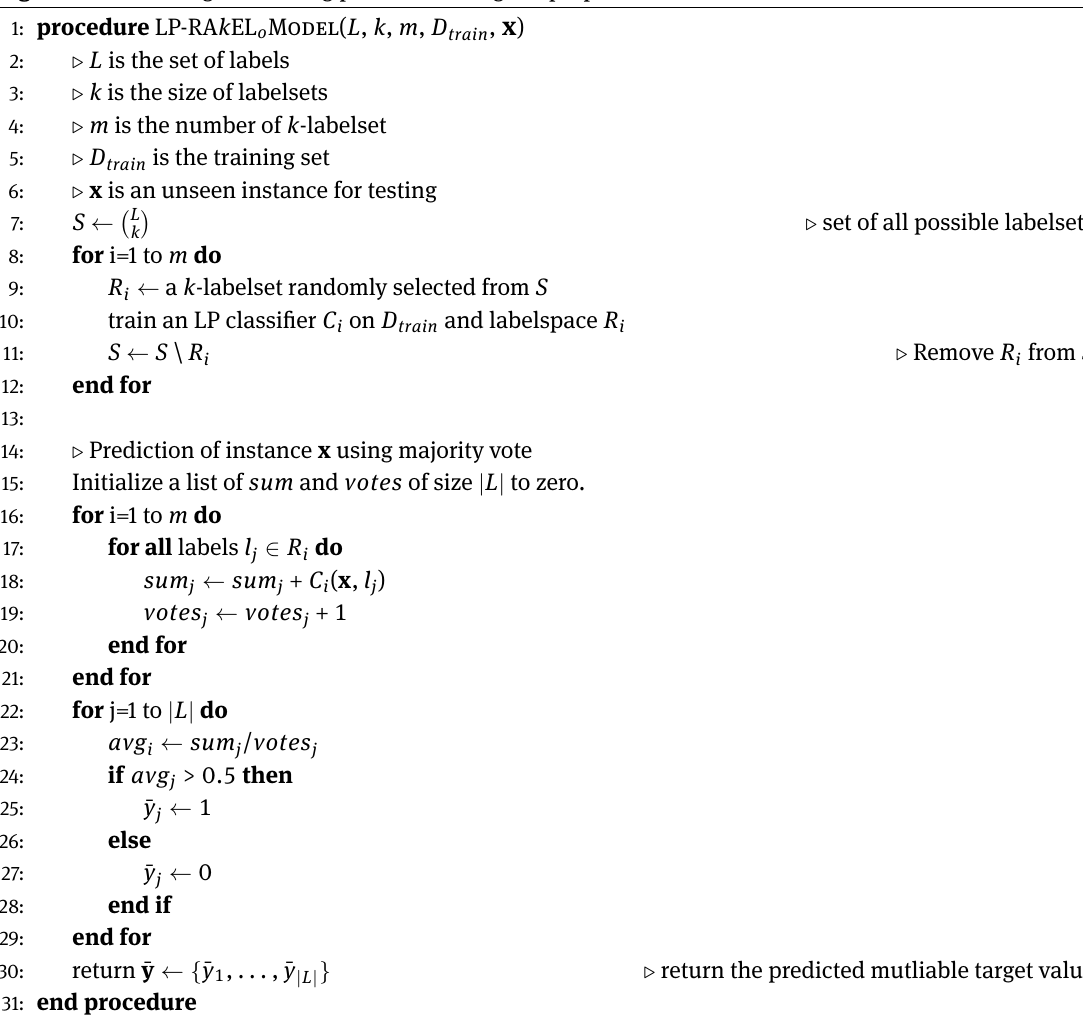
Algorithm 1 Training and testing procedure using the proposed LP + RA k EL